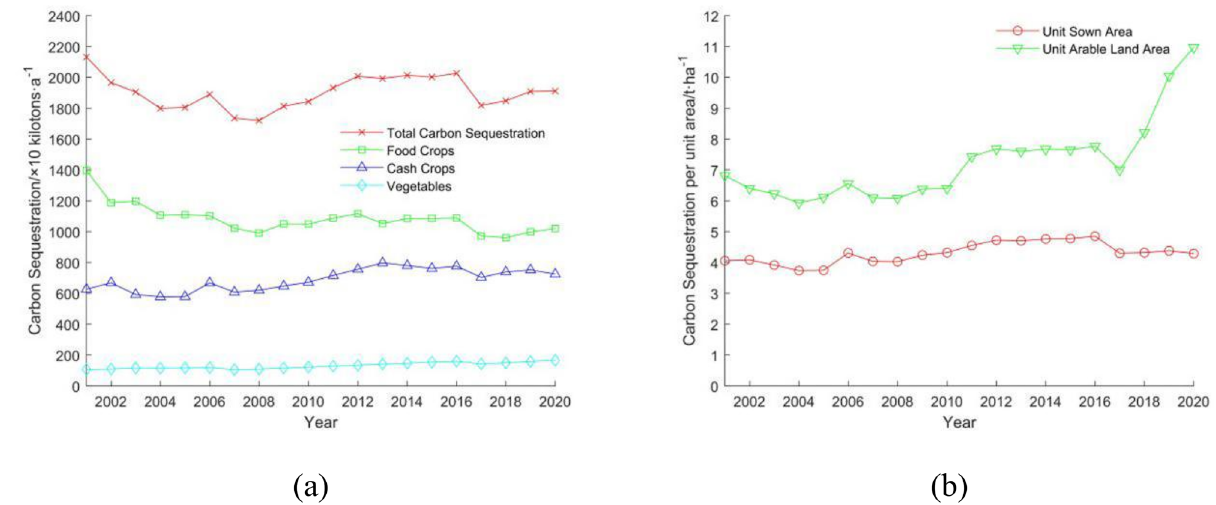
Figure 3. ( a ) Carbon sequestration function of farmland ecosystems in Guangdong; ( b ) inter-annual variation of carbon sequestration function per unit area of farmland ecosystems in